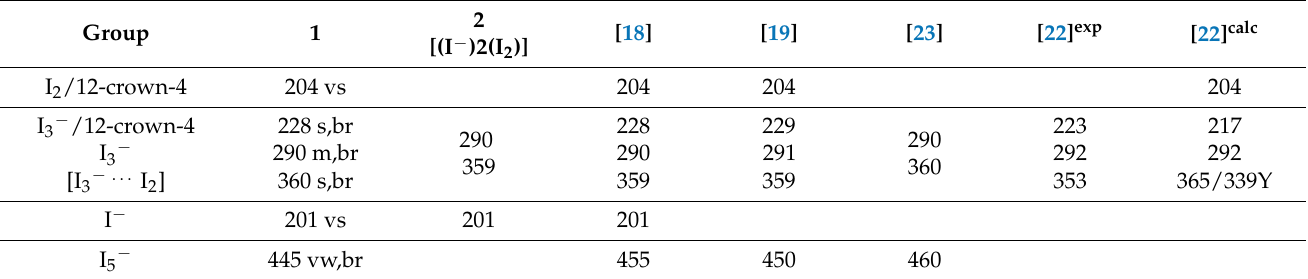
Table 1. The UV-vis absorption signals in the samples [Cu(12-crown-4) 2 ]I 5 (1), [Rb(12-crown-4) 2 ]I 5 Table 1. The UV ‐ vis absorption signals in the samples [Cu(12 ‐ crown ‐ 4) 2 ]I 5 (1), [Rb(12 ‐ crown ‐ 4) 2 ]I 5 (2) [49], and previous reports (2) [49], and previous reports (nm).